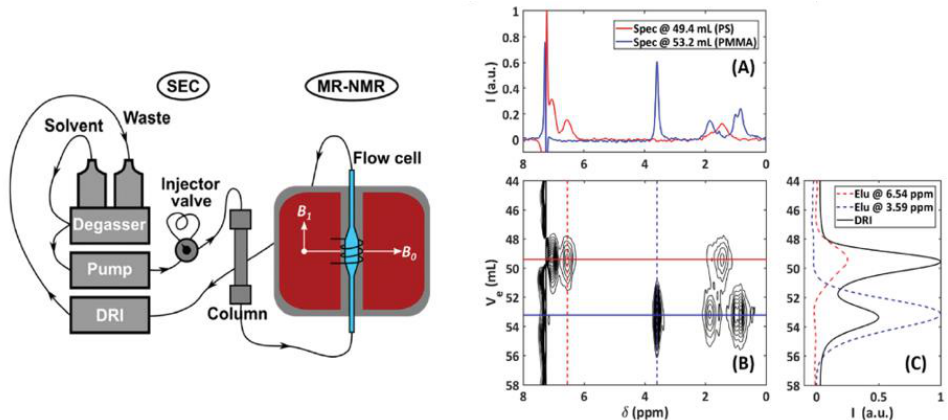
Figure 4. Schematic illustration of the SEC-MR-NMR setup ( left ) and SEC-NMR result obtained for a 1:1 wt% polystyrene (PS)/poly(methyl methacrylate) (PMMA) blend (54,000/23,000 g mol −1 ) ( right ). Although incomplete SEC baseline separation between PS and PMMA was observed (( C ) DRI trace), these polymers featured distinct signals in 1 H NMR spectra ( A ) that was extracted from the 2D data at the peak maxima for each component ( B ). Adapted with permission from [59], Royal Society of Chemistry,